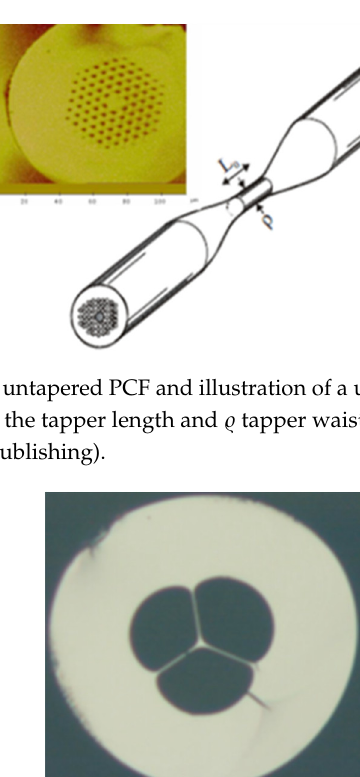
Figure 39. Schematic diagram of the photonic band gap fiber with hollow core. It is filled with tested analyte (n a ) for refractive index measurement (Reproduced from [108], with the permission of Elsevier publishing). Also different interferometry techniques are combined with PCF to make an advanced sensing system. Jha et al. demonstrated an interferometry based sensing probe in which a LMA PCF spliced between two single-mode fiber [109]. Length of the interferometer was 32–mm. This sensor has a high resolution of 2.9 × 10 −4 in RI range 1.38–1.44. During this period hollow nature of PCF successfully combined with selective infiltration technique to make an improvised PCF sensing probe. Using this technique on a probe was reported [110], in which one air hole of a solid core PCF is filled with liquid. Here a strong field overlap takes place between core mode and mode associated with fluid infiltrated waveguide. Its sensitivity is 30,100 nm/RIU with resolution 4.6 × 10 −7 . A dual core PCF works based on mode coupling between two cores. A RI sensing probe was proposed [35] based on a dual core